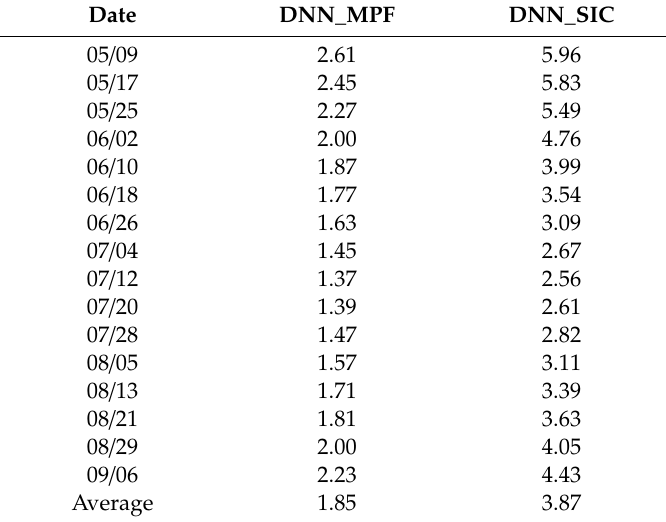
Table 5. Average of the uncertainties (%) for grid-based DNN_MPF and DNN_SIC from May to September during